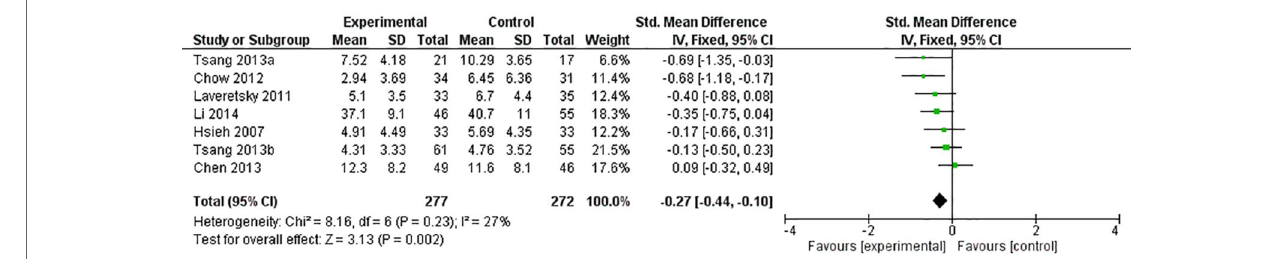
FiGURe 2 | Forest plot of depression.